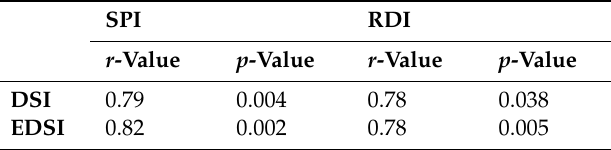
Table 2. The relationship between the enhanced drought severity index (EDSI), the drought severity index (DSI) and the reconnaissance drought index (RDI), the standardized precipitation index (SPI) measured at the meteorological stations in the study area during the 2001–2018